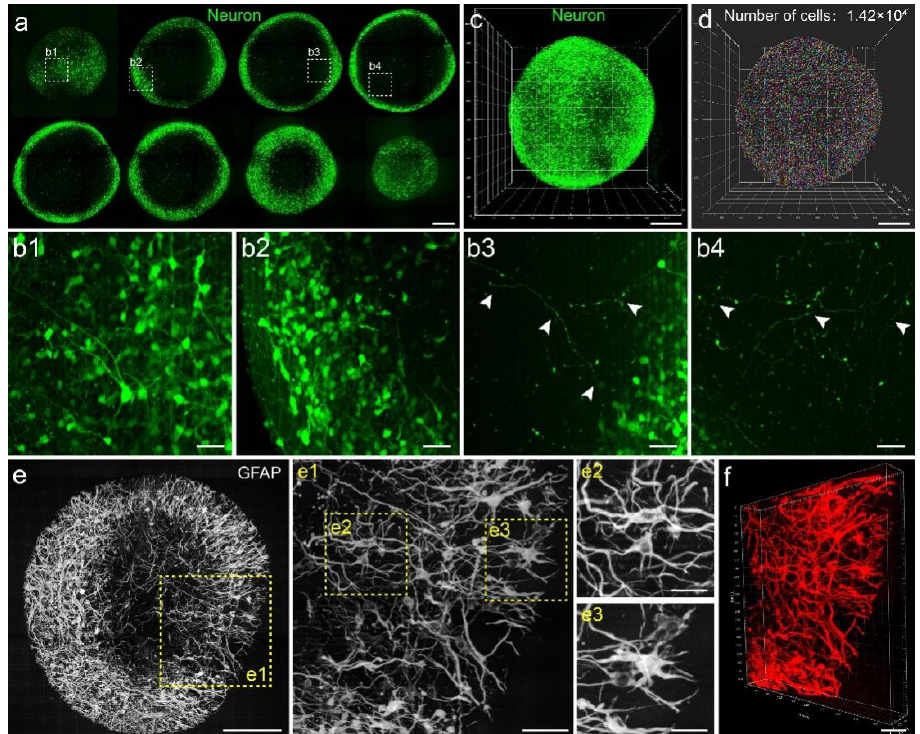
Figure 2. Single-cell morphology analysis in cerebral organoids. ( a ) Maximum intensity z-projections of 200- μ m-thick sections from an organoid showing neurons labeled with EGFP. Scale bar: 200 μ m. ( b1 – b4 ) Higher magnifications of specified regions in ( a ). ( b1 , b2 ) showed the somas, and the arrows in ( b3 , b4 ) indicated the neuronal processes. Scale bars: 50 μ m. ( c ) Three-dimensional view of neurons in an organoid. Scale bar: 200 μ m. ( d ) Spot analysis showing the number of neuronal somas. Scale bar: 200 μ m. ( e ) Maximum intensity z-projection of a 60- μ m-thick section of an organoid showing GFAP + cells. ( e1 – e3 ) were higher magnifications of specified regions in ( e ). Scale bars: 200 μ m ( e ); 50 μ m ( e1 ); 25 μ m ( e2 , e3 ). ( f ) Three-dimensional view of the area showed in ( e1 ). Scale bar: 200 μ m.